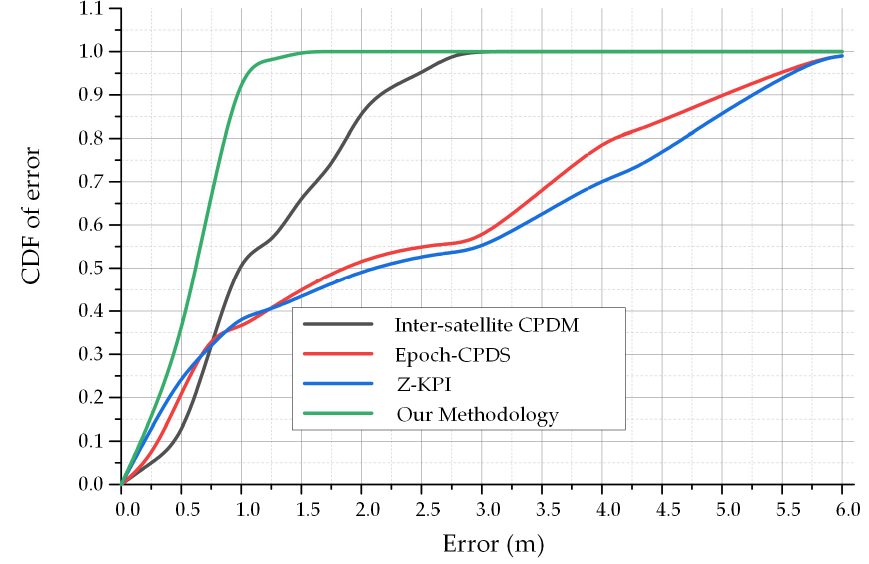
Figure 20. Effectiveness test of multi-dimensional information fusion data